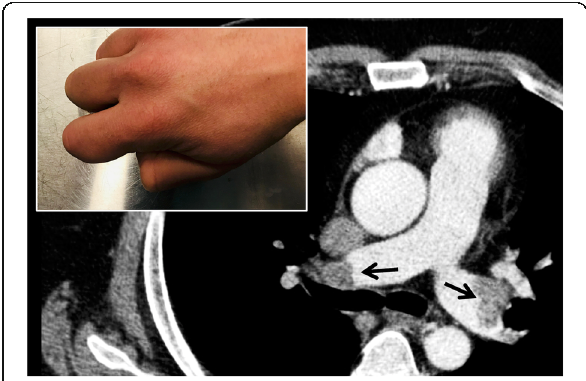
Fig. 14 Knuckle sign. The figure clearly shows evident blood clot (black arrows) due to pulmonary embolism causing abrupt vein thrombosis. The abrupt interruption evokes the appearance of a